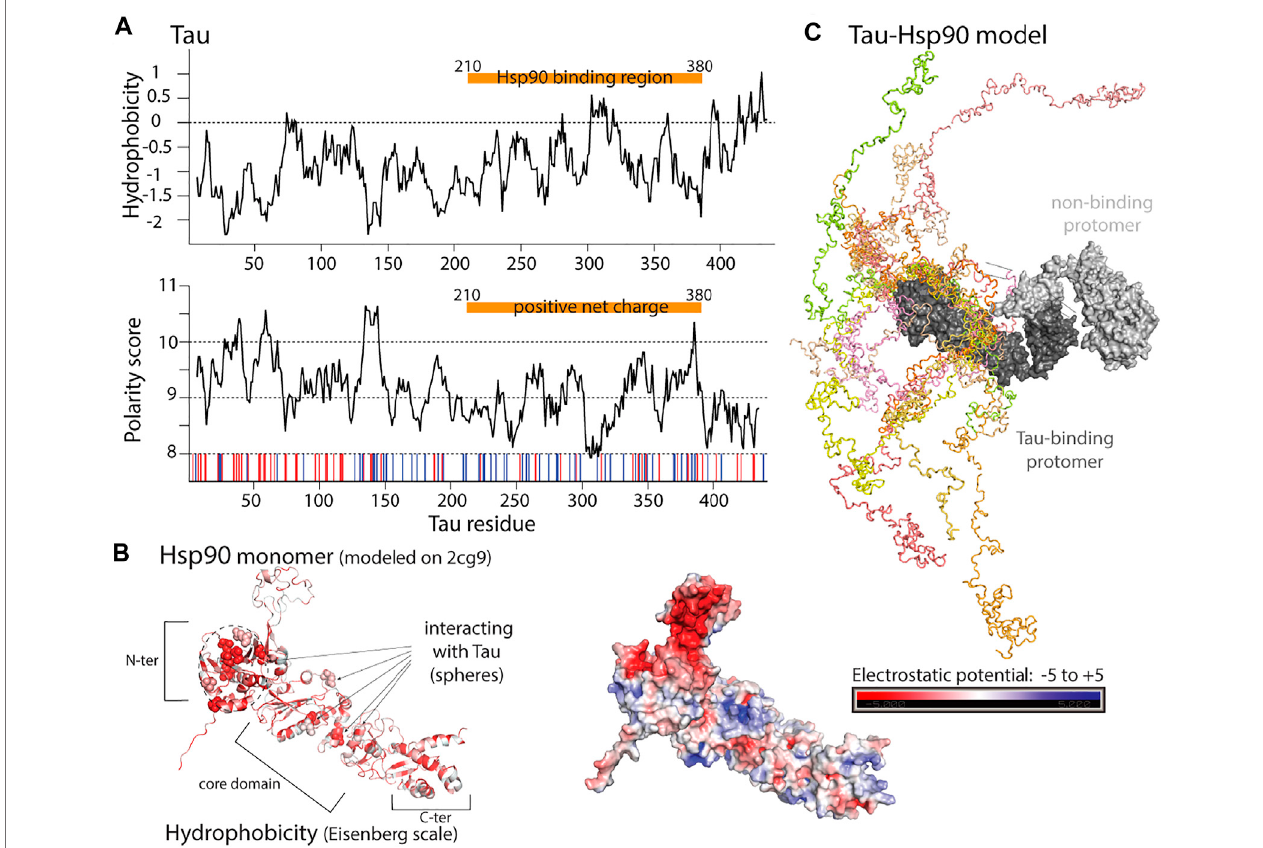
FIGURE 6 | Properties of human Hsp90 and one of its clients, the intrinsically disordered protein Tau. (A) Upper: Hydrophobicity prediction of the full length Tau (isoform F) client (Kyte-Doolittle scale). Lower: Polarity prediction (Grantham scale). Red and blue bars: negatively and positively charged residues. Orange bar: Hsp90 binding region. (B) Hsp90 has hydrophobic residues distributed over an extended Tau binding surface, shown in red based on Eisenberg hydrophobicity scale in the model on the left, and negatively charged surface centered near the Tau binding region (right). Residues shown to be involved in Tau binding [ left, Karagöz et al. (2014)], represented as spheres. Model of human Hsp90, built with the Swiss-Model server Waterhouse et al. (2018) using the PDB structure of yeast Hsp90 bound to Sba1(PDB:2cg9)asatemplate. (C) RepresentationofdifferentTauconformations(indifferentcolors)boundtoHsp90chaperone(darkgray),fromNMRandSAXSdata. The second Hsp90 protomer, not bound to Tau is shown in light gray. Model provided by Dr. Karagöz Karagöz et al.